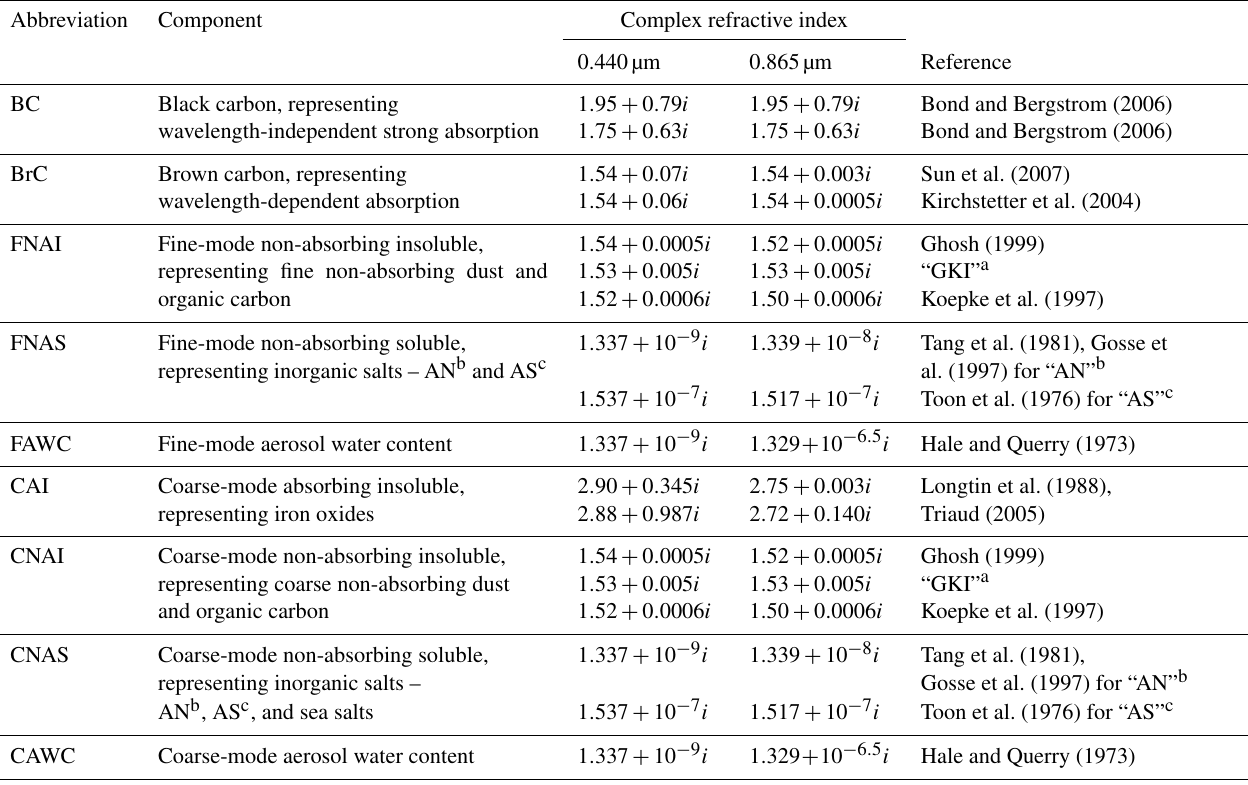
Table 2. Description of aerosol components and complex refractive indices at 0.440 and 0.865µm employed in the GRASP components retrieval approach, as well as those used in the uncertainty